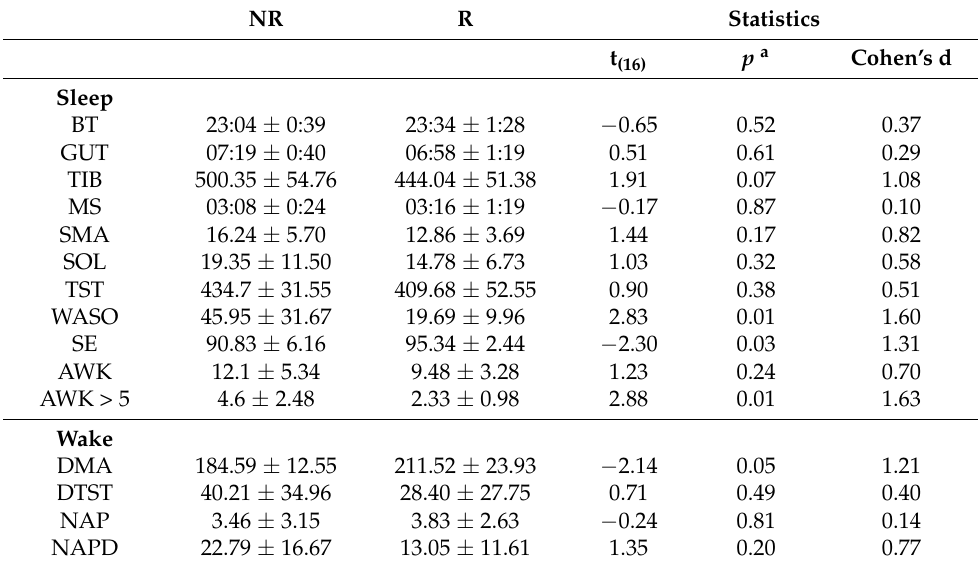
Table 2. Means and standard deviations of actigraphic sleep/wake parameters, measured at T1, in the non-responder (NR) group and responder (R) group.